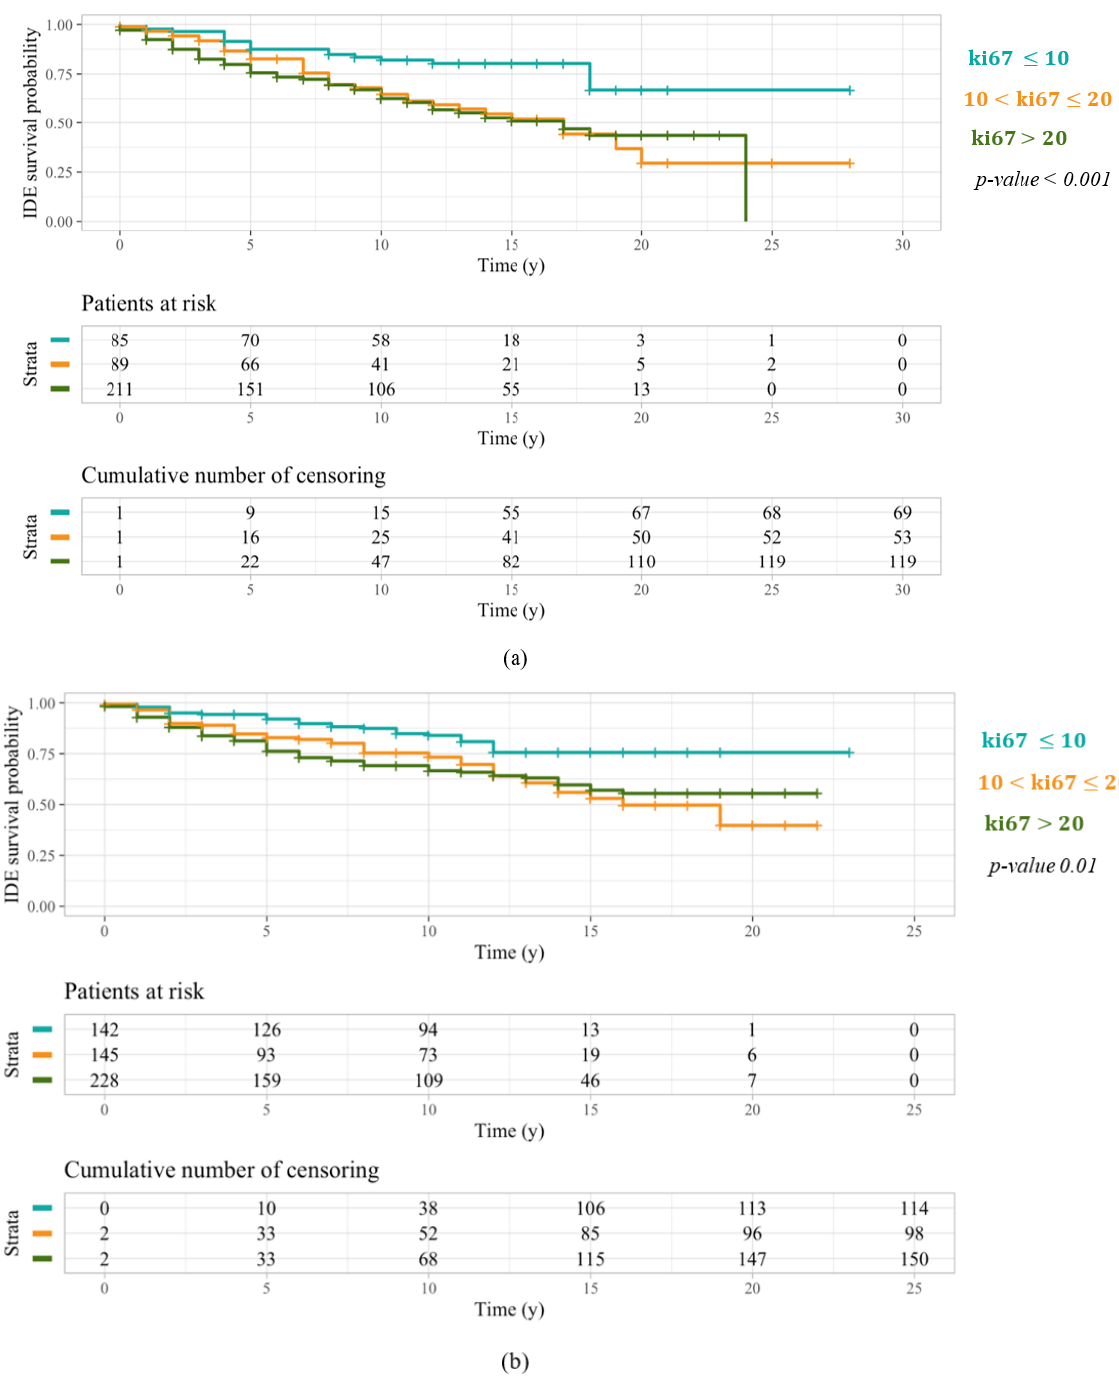
Figure 3. IDEFS curves related to a Kaplan – Meier analysis performed on patients under 50 years old ( a ) and over 50 years old ( b ), both stratified with respect to two ki67 threshold values: 10% and 20%. Similar behavior occurred for patients under 50 years old characterized by a ki67 ranging from 10% to 20% and greater than 20%. Conversely, patients over 50 years old with a ki67 ranging from 10% to 20% had an IDEFS probability greater than patients with a ki67 percentage greater than 20%. Table 2. Values of 5-year and 10-year IDEFS of patients under 50 years old and over 50 years old stratified into three samples with reference to two different thresholds of the cellular marker for proliferation ki67. The p -values resulting from the statistical analysis highlight a statistically signif- icant difference between 10-year IDEFS probabilities of patients under 50 years old and over 50 years old.